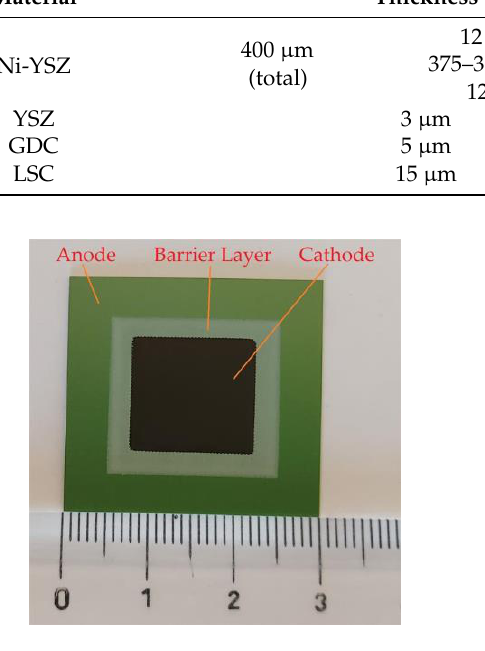
Figure 2. SOFC button cell sample.